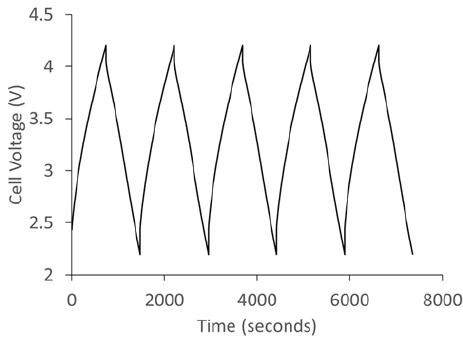
Figure 12. Galvanostatic charge/discharge curve of lithium ion capacitor cycled between 2.2 V and 4.2 V at 0.1 A/g.